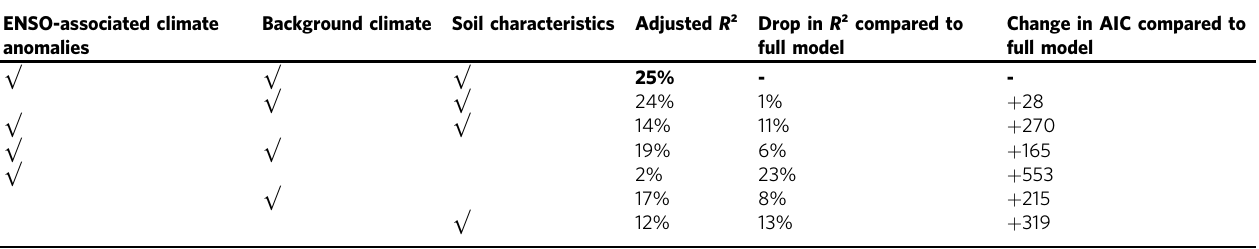
The fi nal, full model is highlighted in bold. All values are rounded to nearest